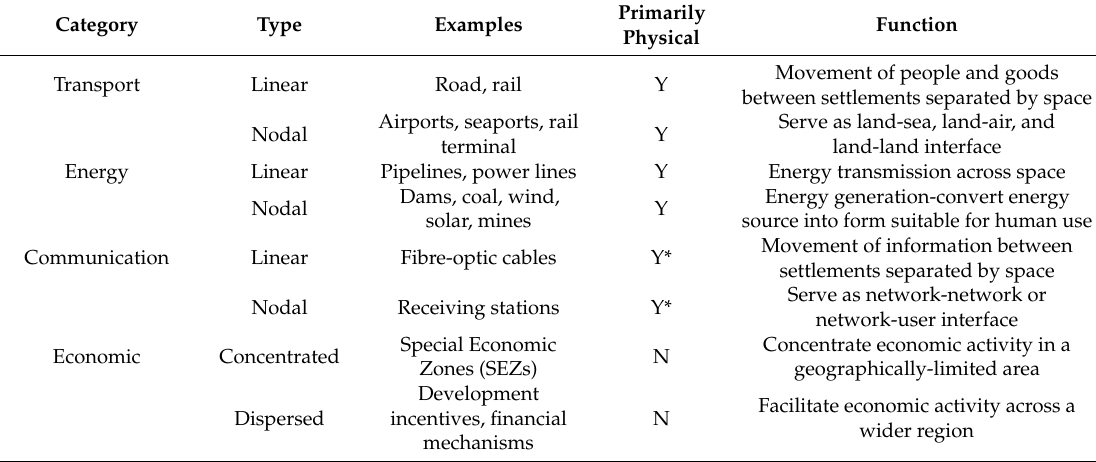
Table 3. Typology of BRI infrastructure according to type and